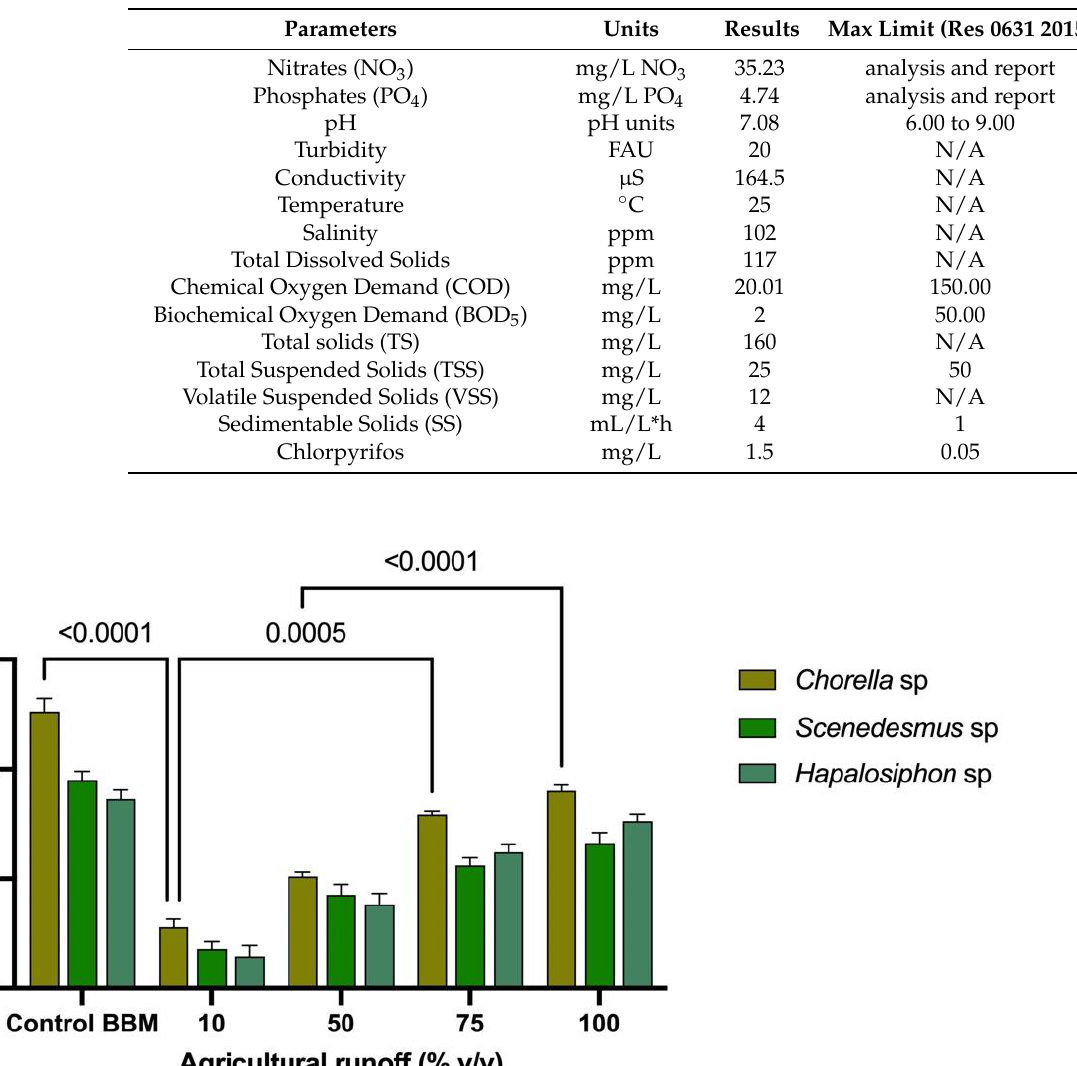
Table 1. Chemical analysis of agricultural runoff.